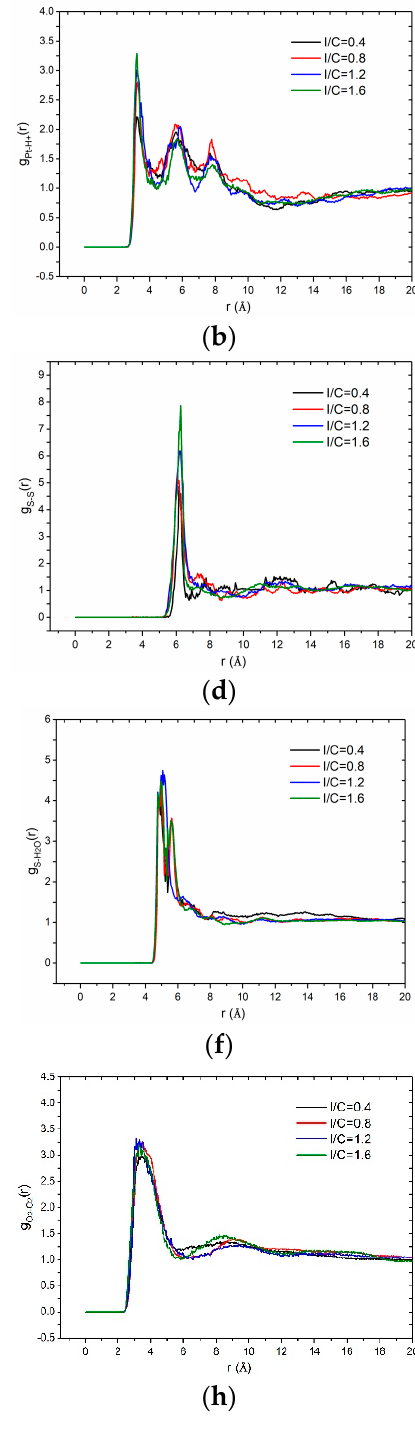
Figure 6. RDF values of the multi-components as a function of ionomer-to-carbon ratios: ( a )